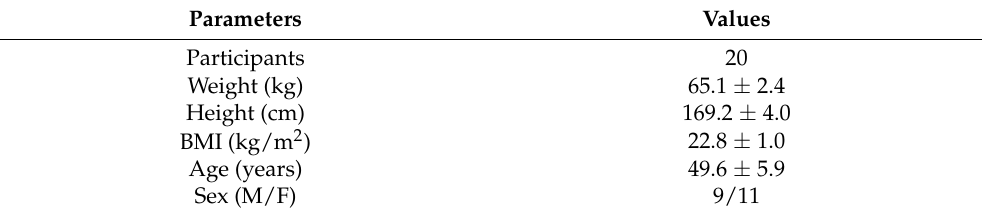
Table 1. Features of enrolled healthy subjects.